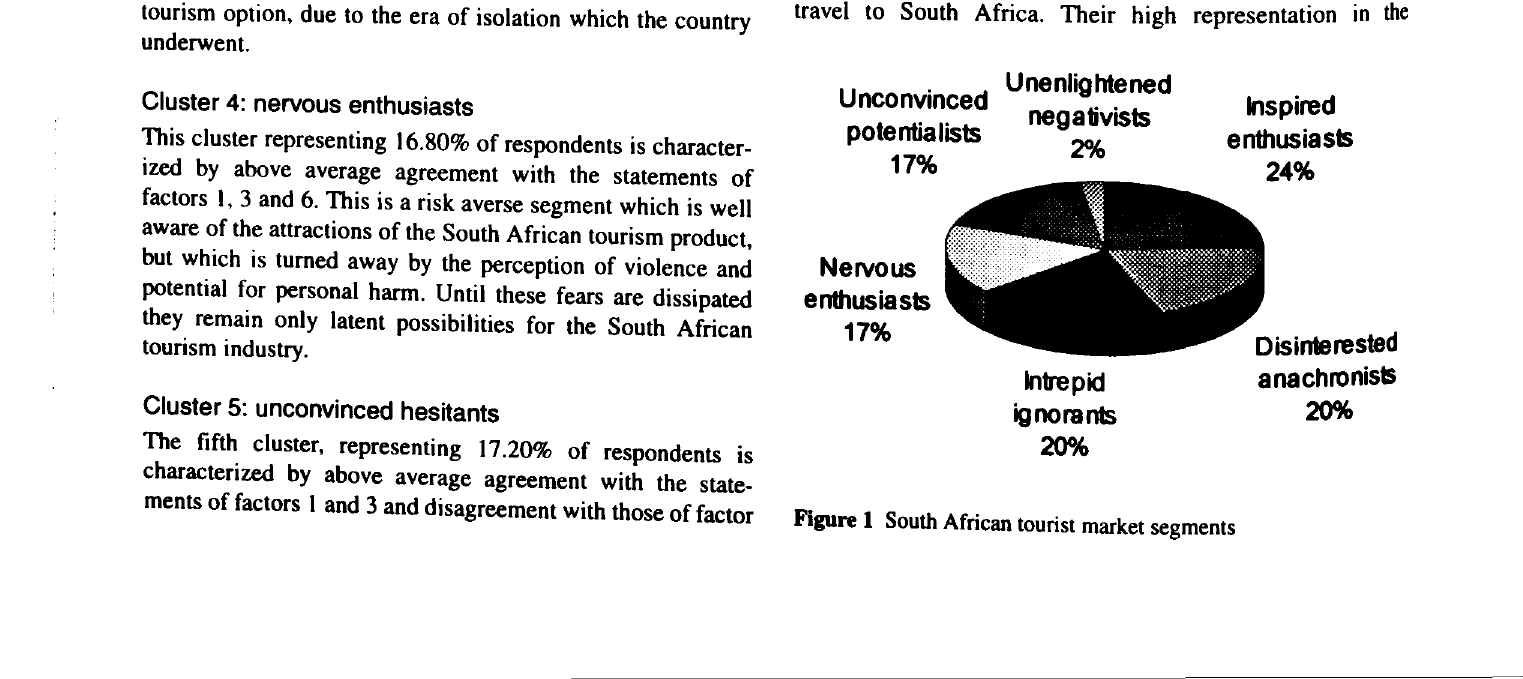
Figure 1 South African tourist market